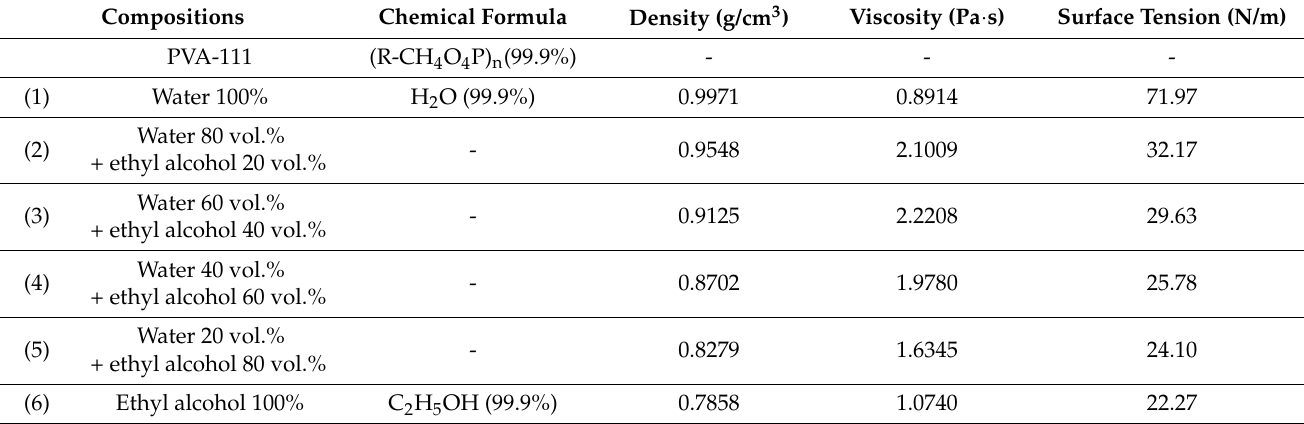
Table 1. Viscosity and surface tension values of the water-ethyl alcohol solutions with different compositions.